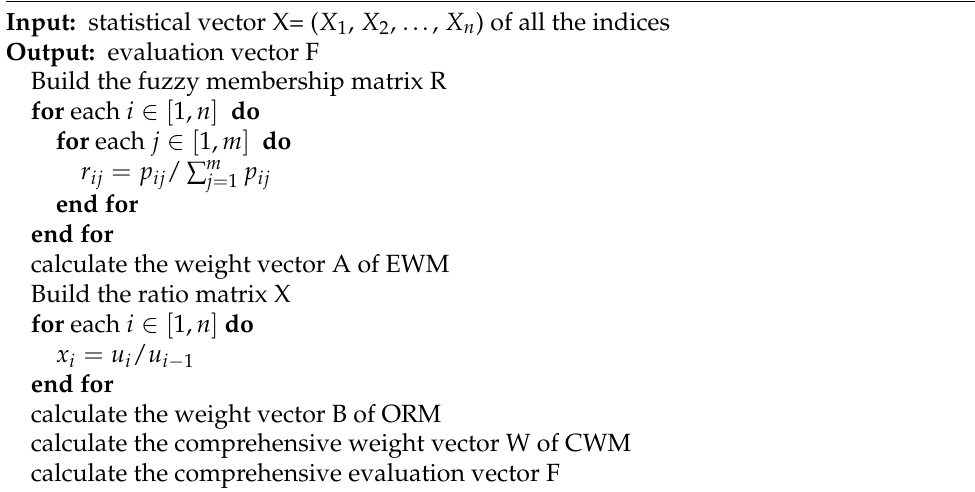
Algorithm 1 General process of fuzzy comprehensive evaluation in the risk assessment system